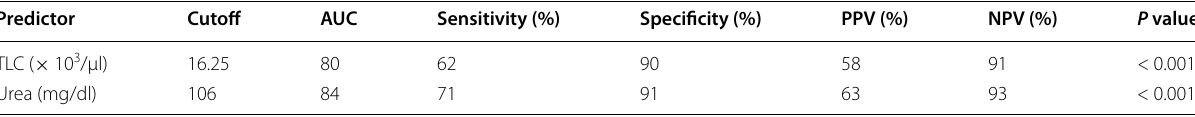
TLC Total leukocytic count, AUC Area under the curve, PPV Positive predictive value, NPV Negative predictive